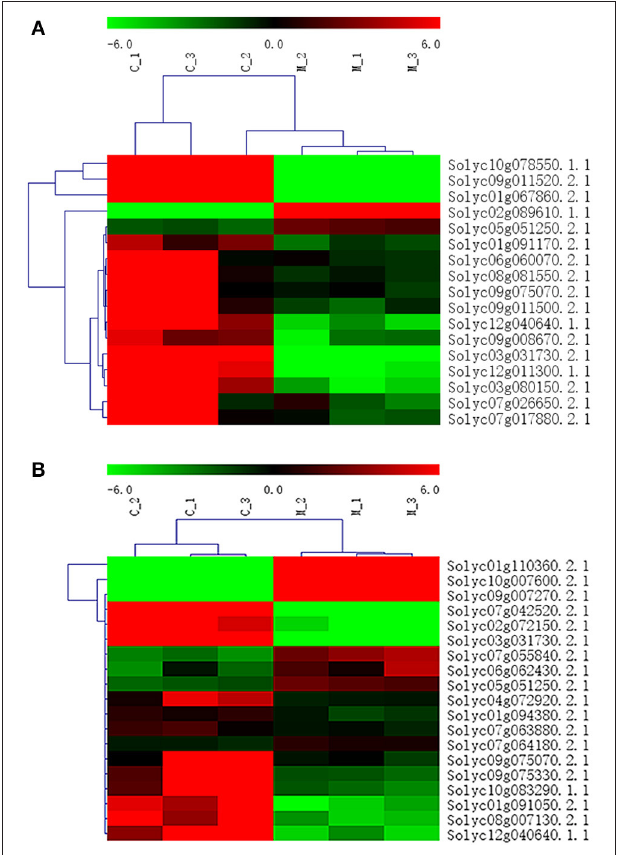
FIGURE 4 | Heat map representation of differentially displayed genes. (A) Amino acid metabolic pathway, (B) Carbohydrate metabolic pathway.